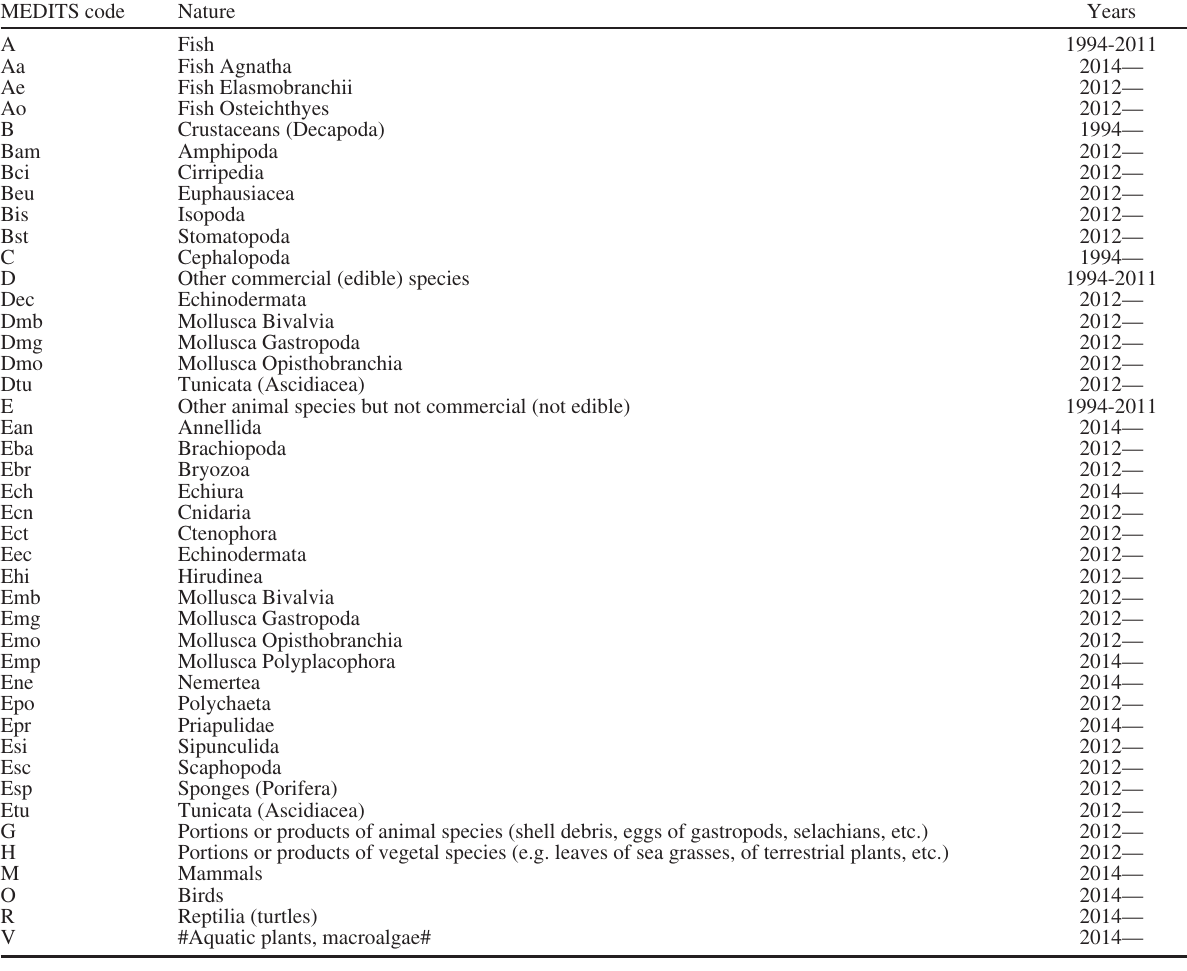
Table 2. – List of the taxonomic categories used in the MEDITS bottom trawl surveys with code specification and year of introduction and use. The symbol “—” indicates that the taxonomic category is still used. MEDITS